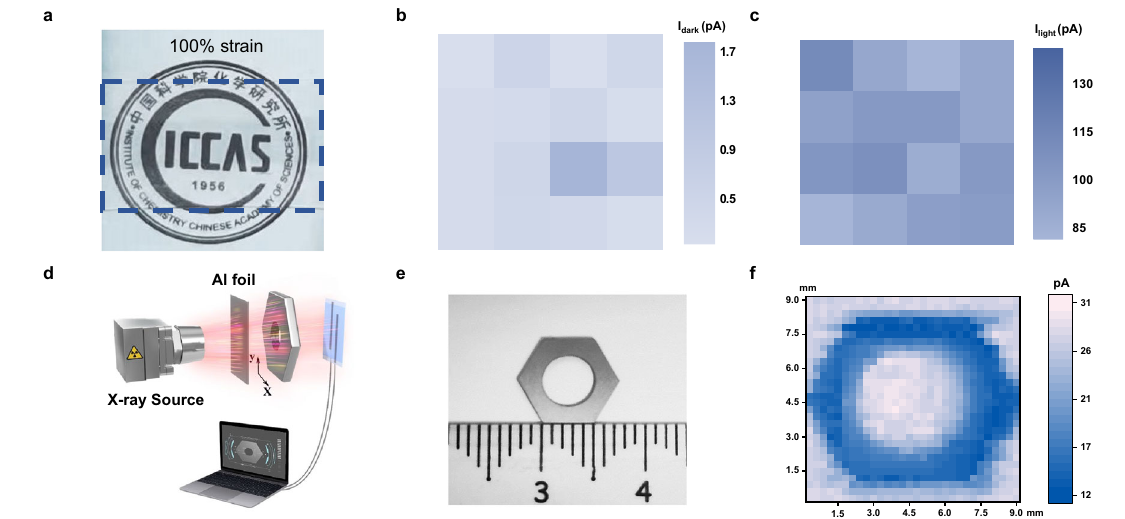
Fig. 4 | X-ray imaging of the intrinsically stretchable n-type semiconductor fi lms. a Images showing high transparency and stretchability of the hybrid semi- conductor fi lm. b Thedarkcurrentand c theX-rayphotocurrentextractedfrom16 working devices, respectively. All the devices biased at V DS =60V ( V G =0V), were irradiatedwithadoserateof3.5 μ